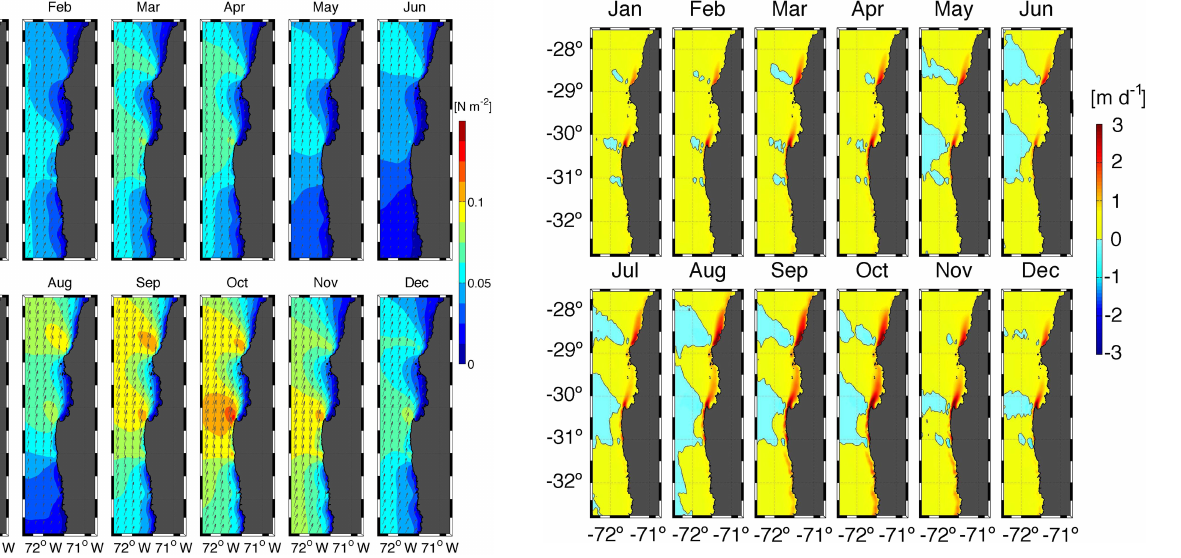
Figure 4. Wind stress annual cycle obtained from the simulation at 4km resolution (for 2007–2012). Color represents the magnitude of wind stress (in Nm − 2 ) and the arrows indicate the wind stress direction.